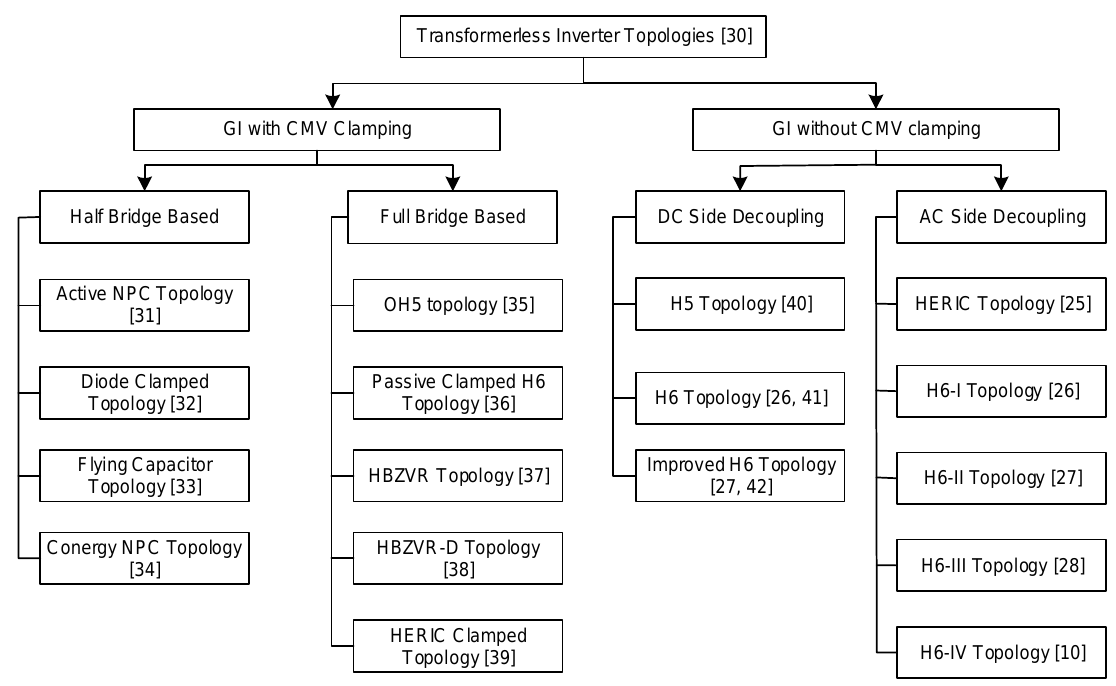
Figure 2. Transformerless inverter topologies: A classification overview.